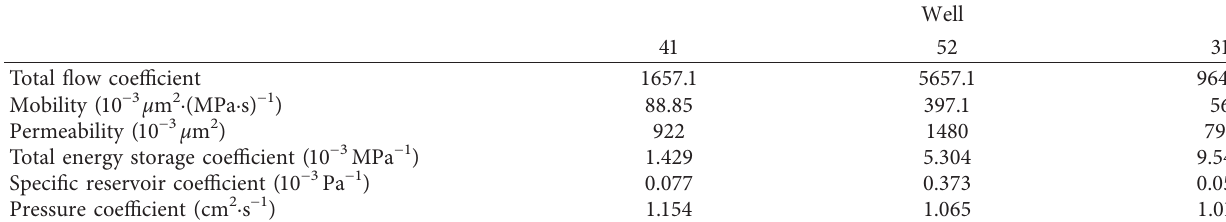
Figure 12: 3D characterization of intralayer seepage barriers with a lateral accretion pattern. Table 2: Interference well test interpretation results in well block